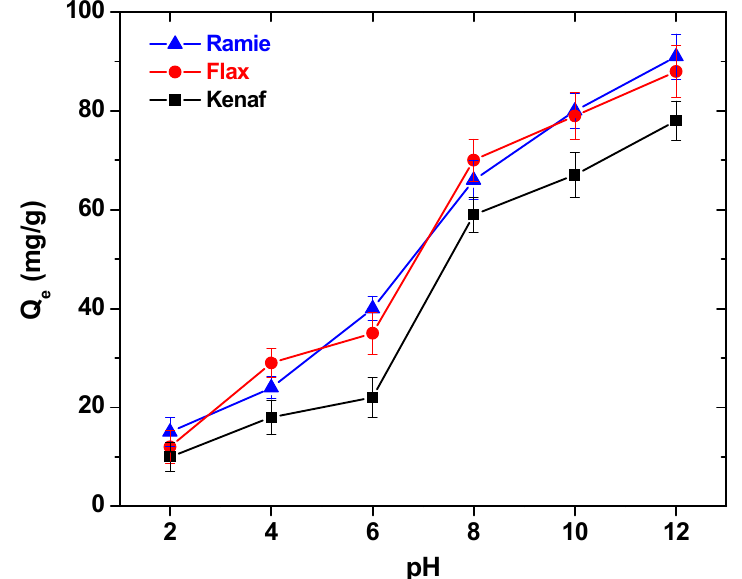
Figure 4. Effect of pH on the BY37 removal with adsorption onto fibers (adsorption conditions: C 0 = 100 mg · L − 1 , pH = 2–12, T = 25 ◦ C, N = 160 rpm, m = 0.1 g, V = 100 mL, and t = 24 h).